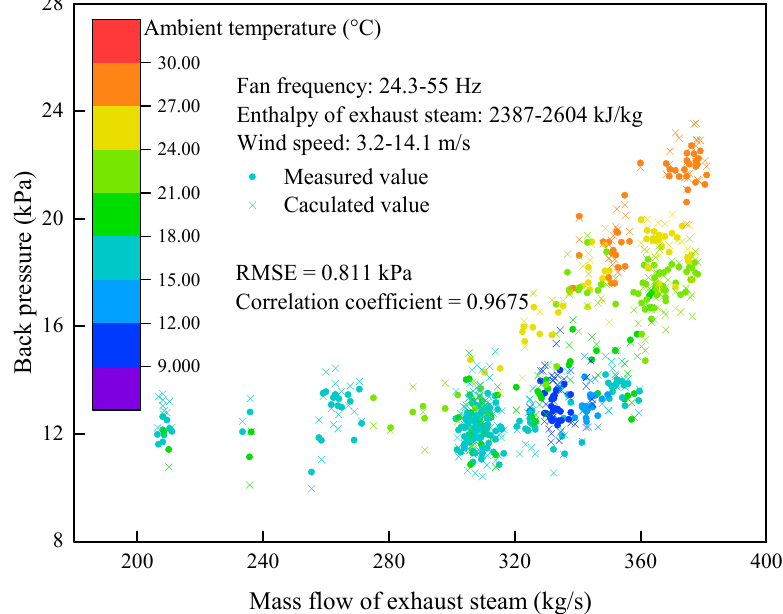
Figure 6. The validation between the calculated and the measured values (also discussed in [41]).